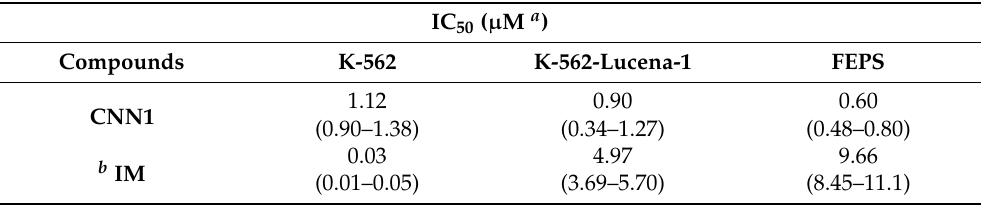
Table 1. Cytotoxic activity expressed as IC 50 in µ M and with its respective confidence interval of 95% in K-562, K-562-Lucena-1 and FEPS cell lines, after 72 h of